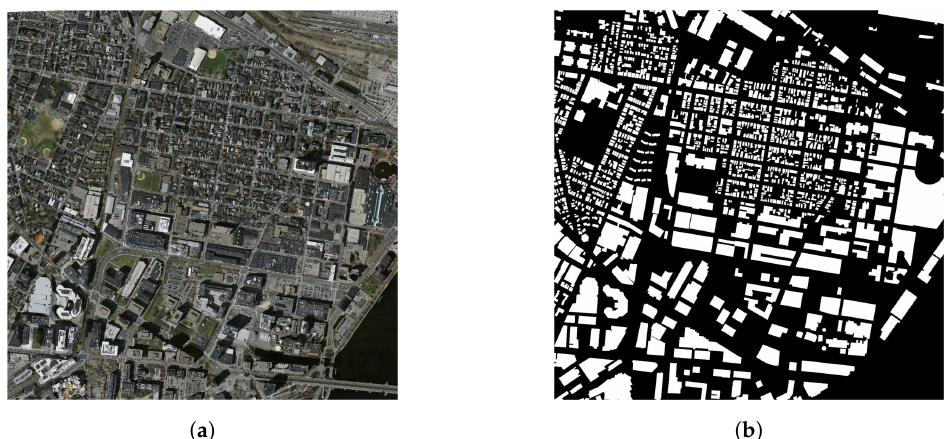
Figure 4. An example of the Massachusetts Building Dataset. ( a ) Original image; ( b ) Ground